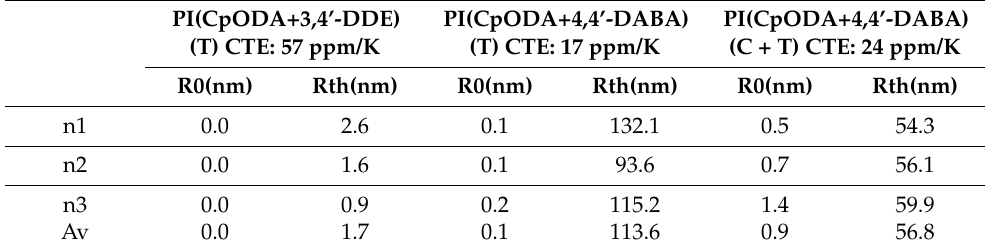
Table 4. The normalized retardation values of the CpODA-based polyimide